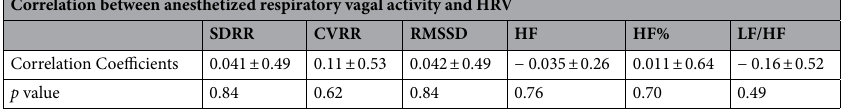
Correlation between anesthetized respiratory vagal activity and HRV